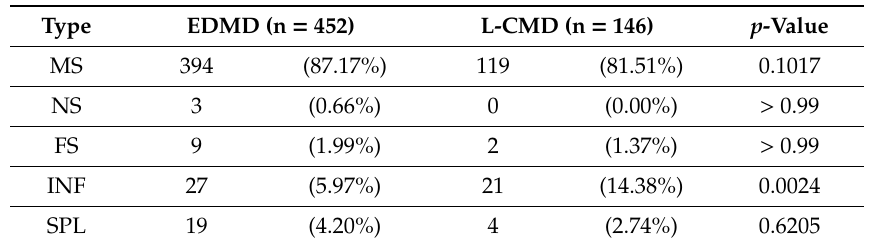
Table 3. Type of mutations among Emery–Dreifuss (EDMD) and LMNA -related congenital muscular dystrophies (L-CMD) index cases.